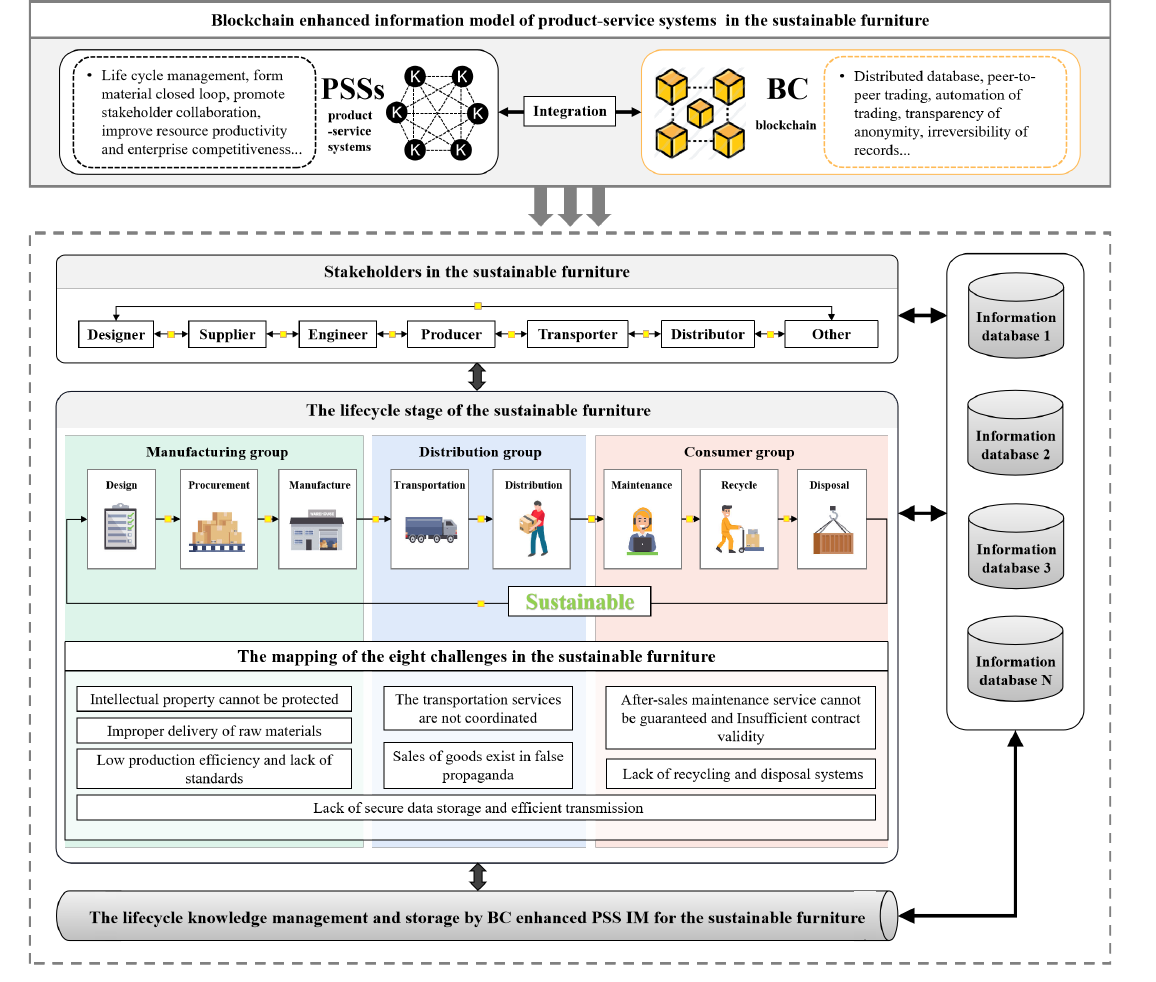
Figure 9. BC-enhanced PSSs IM in sustainable furniture (generated by authors).